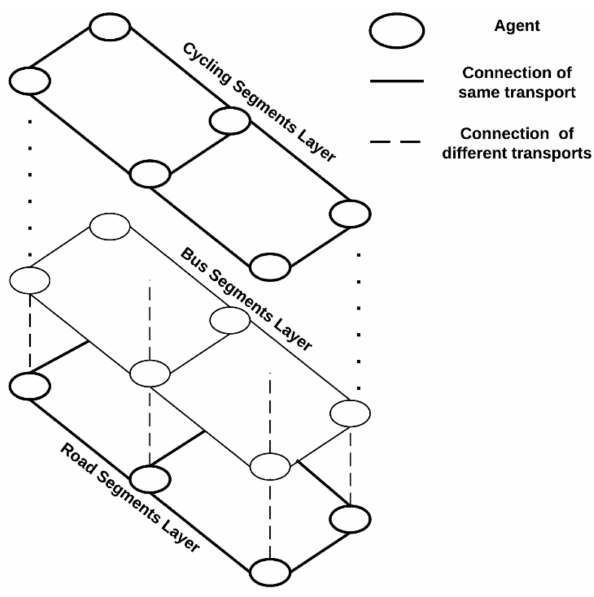
Figure 6. Interconnected layers of transport